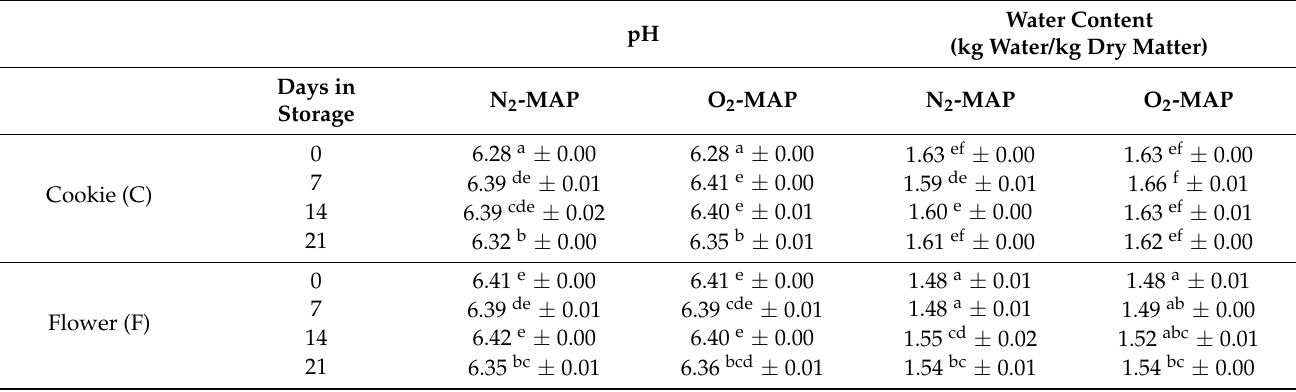
Table 4. pH and water content in the two forms (C and F) of 3D-printed products stored for 21 days in the two modified atmospheres (N 2 -MAP and O 2